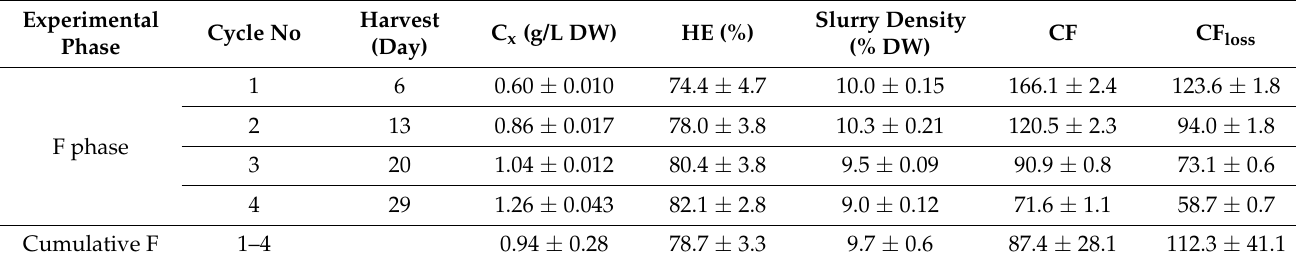
Table A2. Harvesting efficiency (HE, % of the biomass retained from the filter), dry content (slurry density, % DW), and the concentration factor (CF and CF loss ) of the harvested algal slurry after single-stage 40 µm filtration (Filtra ® model FTI-0800), compared to the culture concentration at the time of harvesting (C x , g/L) for A. platensis BEA 1257B in the 8000 L raceway pond inside the greenhouse.